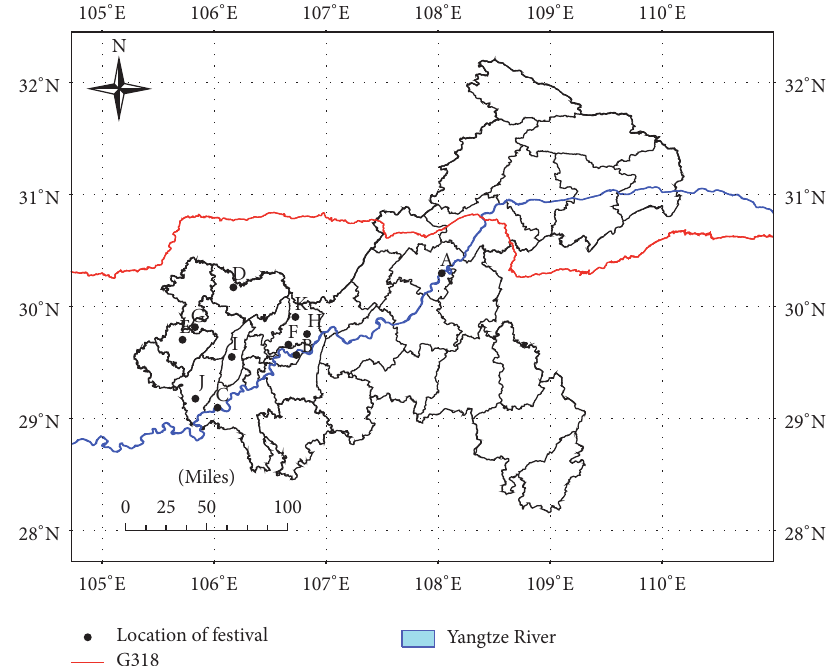
Figure 2: Location of fruit-picking tourism festival in Chongqing (A, Citrus Cultural Festival of Zhong County; B, Loquat Festival of Jiangnan District, C, Rural Tourism and Late Maturing Citrus Fruit-Picking Festival of Shimen Town, Jiangjin District, D, Loquat Fruit-Picking Festival ofGulouTown,E,LoquatTourismCulturalFestivalofDazuDistrict,F,CherryFestivalofYufengshanTown,G,CherryFestivalofShuangshan Town, H, Grape Festival of Sichuan Town, I, Grape Tourism and Culture Festival of Bishan District, J, Watermelon Tourism and Cultural Festival of Yongchuan District, and K, Waxberry Cultural Festival of Xinglong